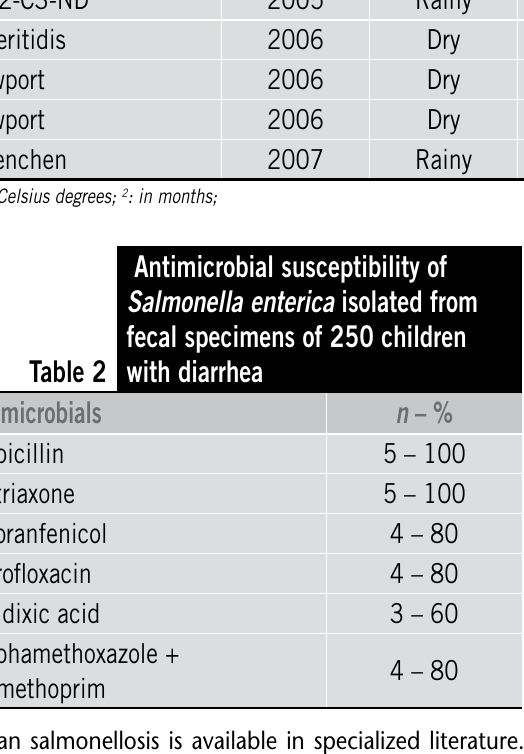
Table 1 Association among Salmonella enterica serovar and clinical and epidemiologic data Salmonella enterica